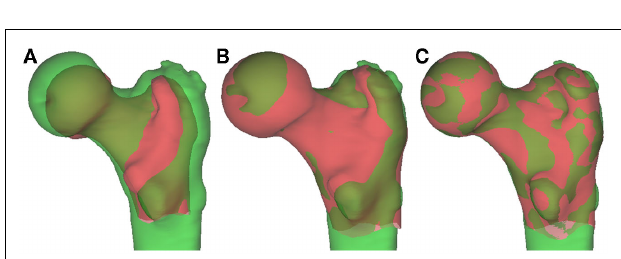
FIGURE 10 | Shape manipulation with B-spline deformation. (A) The “canonical” proximal femur (red) and the test femur (green) are overlaid. (B) The “canonical” femur is changed in scale and position to approximate a best fit. (C) The “canonical” femur is warped through B-spline deformation to fit the test femur, giving “modes” of variation ranked according to importance with PCA. Image courtesy of Dr. GrahamTreece, Department of Engineering, University of